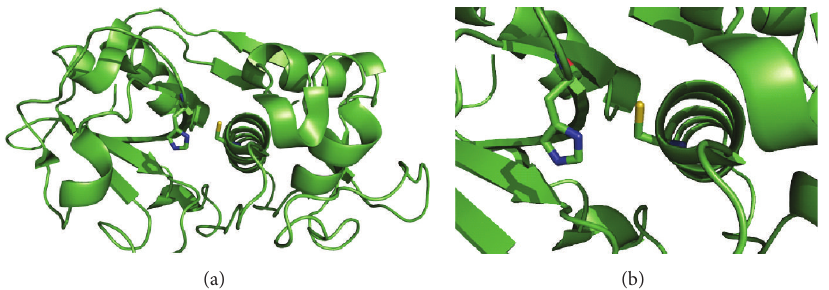
Figure 1: (a) Model of the cruzipain. (b) Active site of cruzipain.